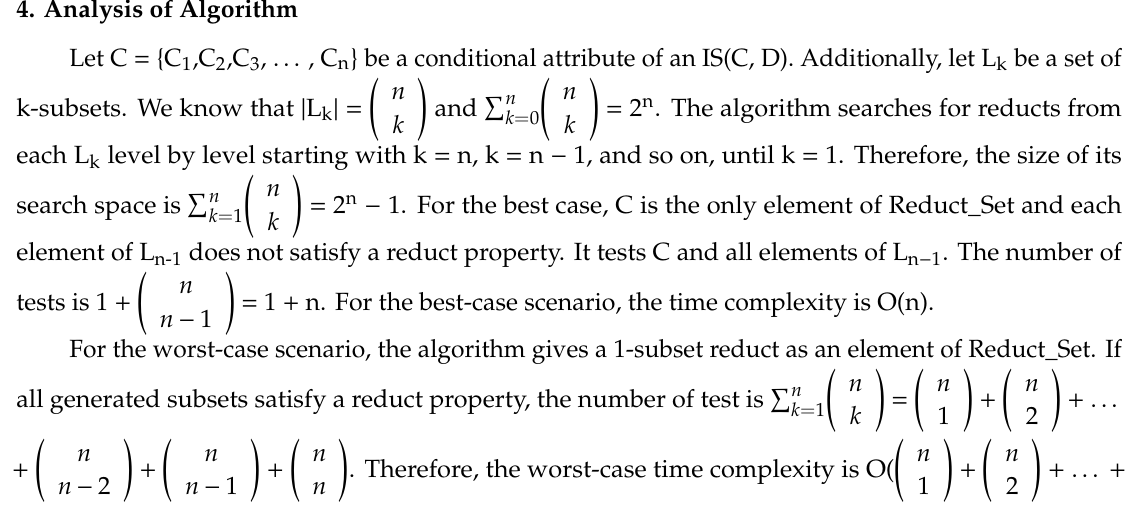
Figure 4. updateNonReduct_Set(C’) procedure.